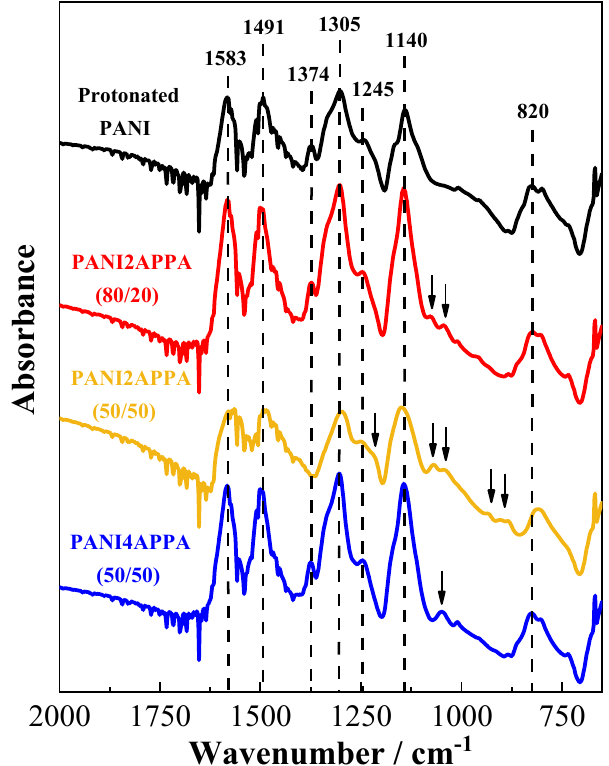
Figure 2. FTIR spectra obtained for protonated PANI (black line), PANI2APPA feed ratio 80/20 (red line) and 50/50 (orange line), and PANI4APPA feed ratio 50/50 (blue line).